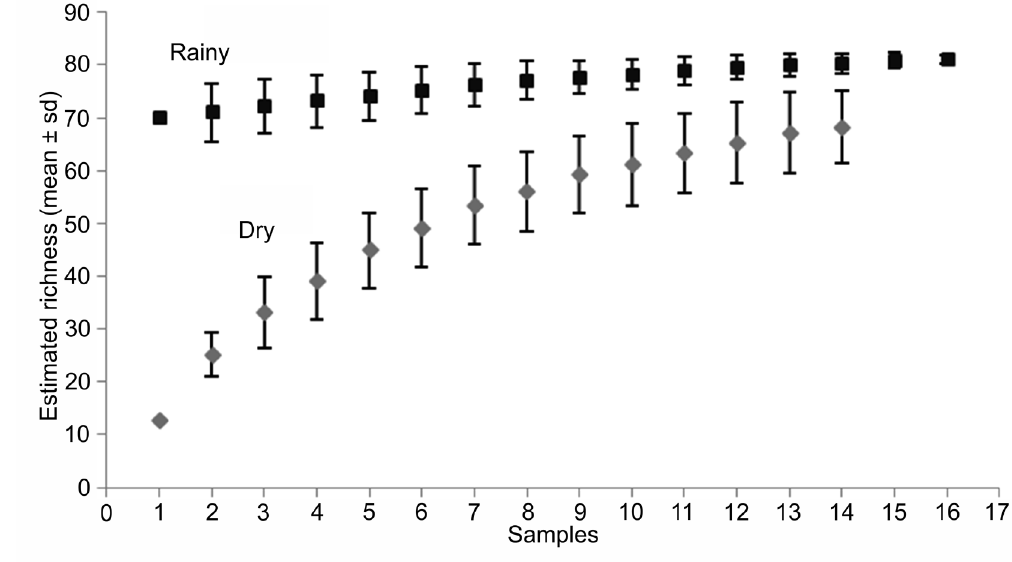
Figure 2. Rarefaction curves for the samples caught during dry and rain seasons using the bootstrap richness